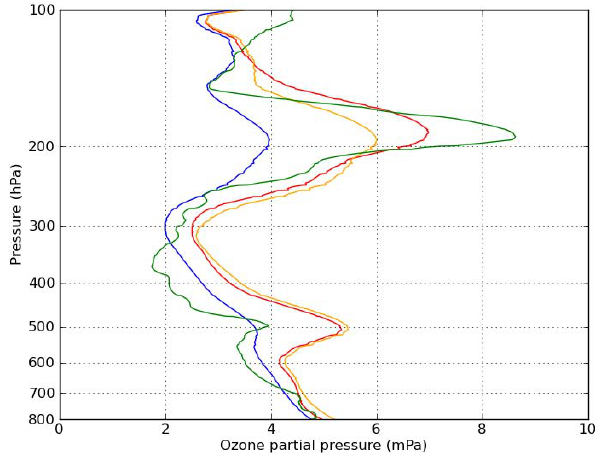
Fig. 12. Ozone profiles, mPa, from a sonde over Payerne (46.5 ◦ N, 6.6 ◦ E; green line, launched at 11:00UT on 17 July 2009), from the free MOCAGE run (blue line), from analyses (red line) and fore- casted run initialised with MLS anlyses at 00:00UT on 15 July 2009 (orange line). All experiments are from High Resolution (0.2 ◦ )